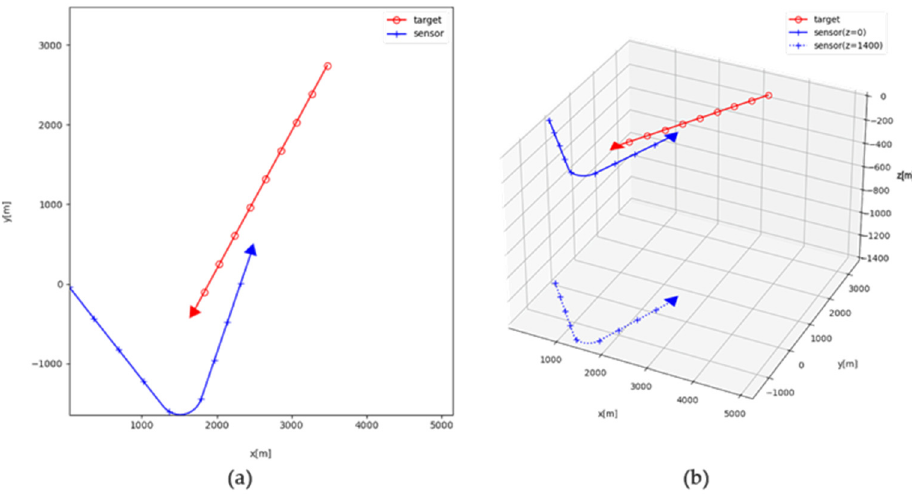
Figure 3. Target and sensor geometry ( a ) in horizontal plane and ( b ) in 3D space.